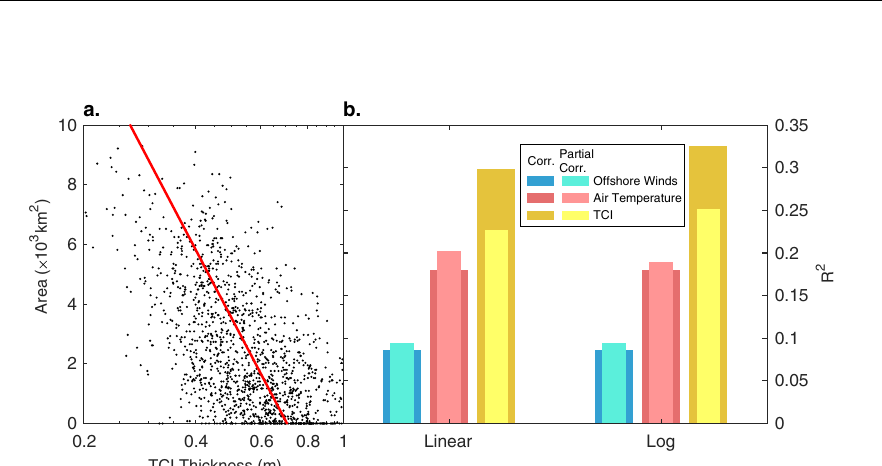
The fi rst number in each cell is R 2 , and the number in the brackets is r. The fi rst row shows the partial correlations. The asterisk (*) means that it has not passed the signi fi cant test ( p = 0.005). The parameter numbers in the fi rst row match parameters in the fi rst column.